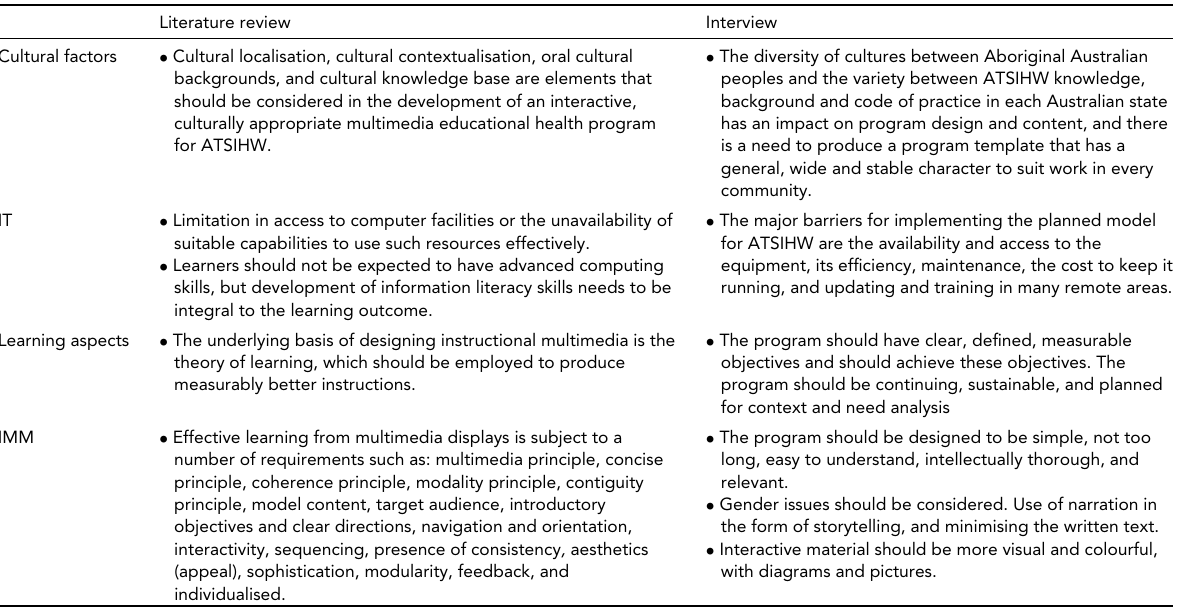
Comparison Between the Results of the Research